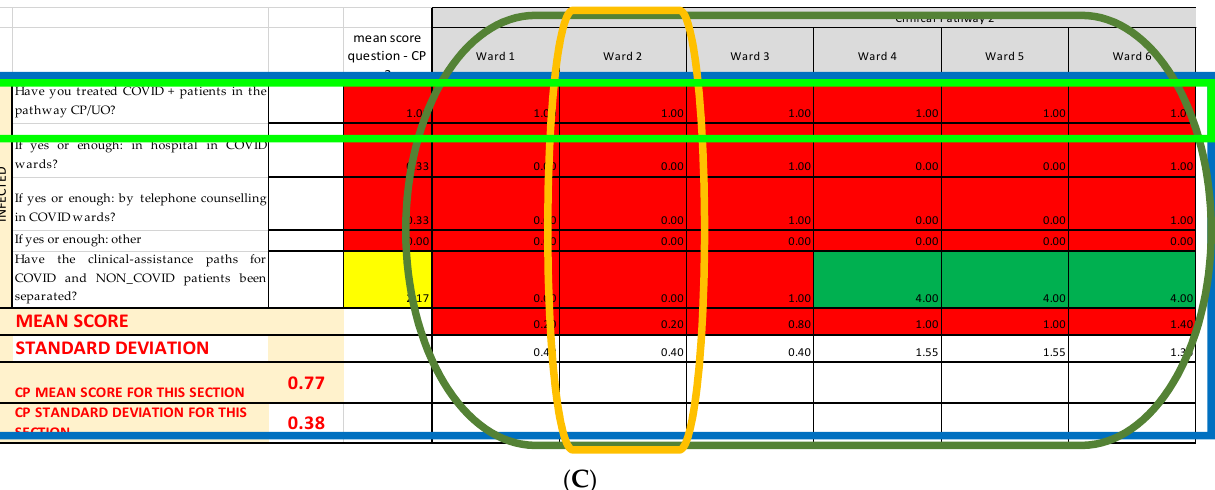
Figure 6. Example of SPRIS (Streetlight PRIority Swot) application. ( A ) Photograph of the complete picture given by the Streetlight color system sheet, showing the first three Questionnaire Sections for two of the considered CPs. ( B ) Extraction of the first Questionnaire Section of the first CP. We can read the data about each item/ward (answer score in related cell; the gray circle shows as an example the score of item 1 reached by Ward 3) or about each item/CP (mean score of the answers of a single item for the CP as a whole, shown as an example for item 4 by the purple circle), or about each item/total CPs (mean score of the answers regarding a single item for all the CPs, shown as an example for item 2 by the light blue circle); for each Questionnaire Section of each CP a mean score is calculated (pink circle). ( C ) Extraction of the fourth Questionnaire Section of the second CP. Horizontally, we can find the data about the single question (neon green rectangle) and the fourth Questionnaire Section (blue rectangle); vertically, the data about one specific CP (dark green circle) and one of the first OU/wards (orange rectangle) are reported.